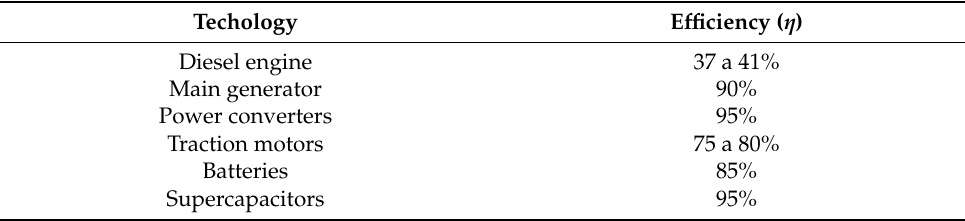
Table 1. Power conversion efficiencies of the main locomotive technologies